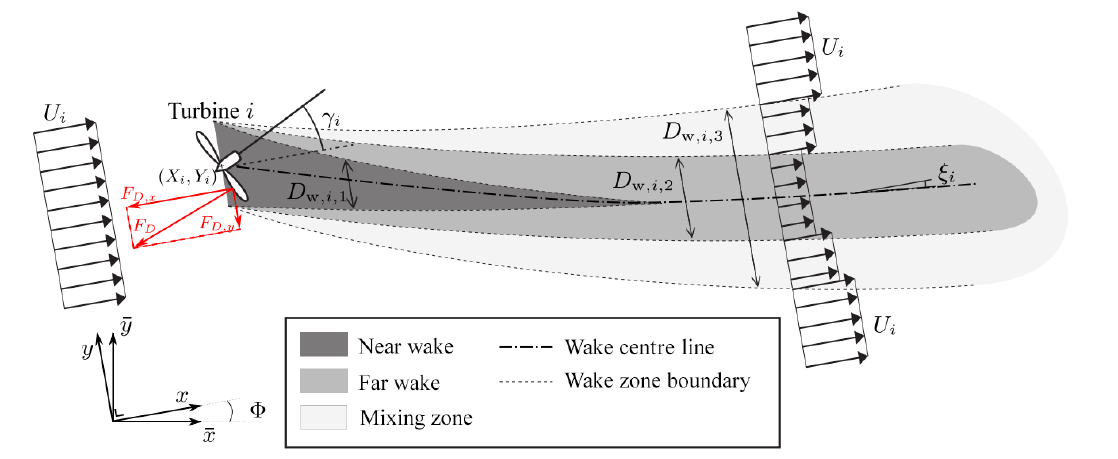
Figure 1. A schematic visualization of the wake model in FLORIS, containing three discrete wake zones. Furthermore, active wake deflection by purposely misaligning the turbine rotor with the flow is shown (cf. Fig. 4a in Gebraad et al., 2016).